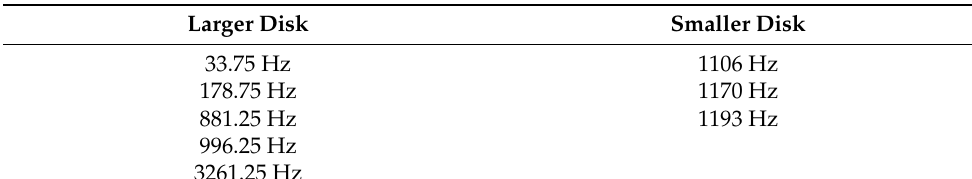
Figure 7. The FRFs of the larger ( a ) and smaller ( b ) disks. Table 1. Natural frequencies of vibration of the tested disks corresponding to mode shapes presented in Figures 8 and 9.